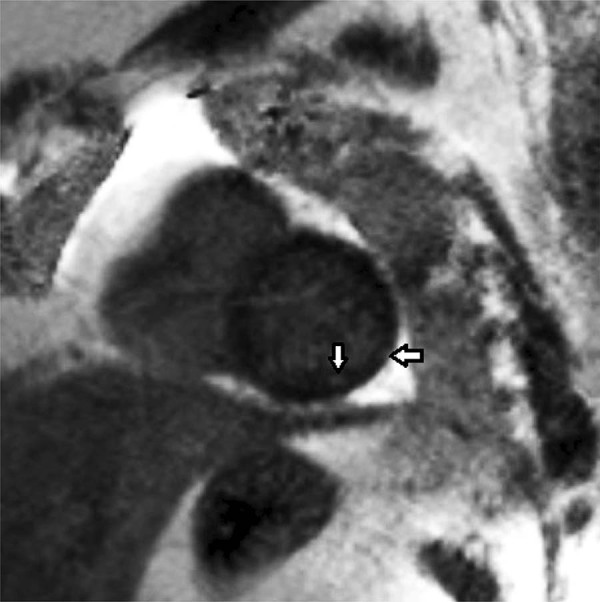
–
Short- axis delayed contrast-enhanced PSIR cardiac MR image, demonstrating focal subendocardial and subepicardial enhancement areas localized into the inferior and inferolateral left ventricular walls (arrows). These hyperintense areas reflect scattered fibrotic scar tissues in the LAD territory.